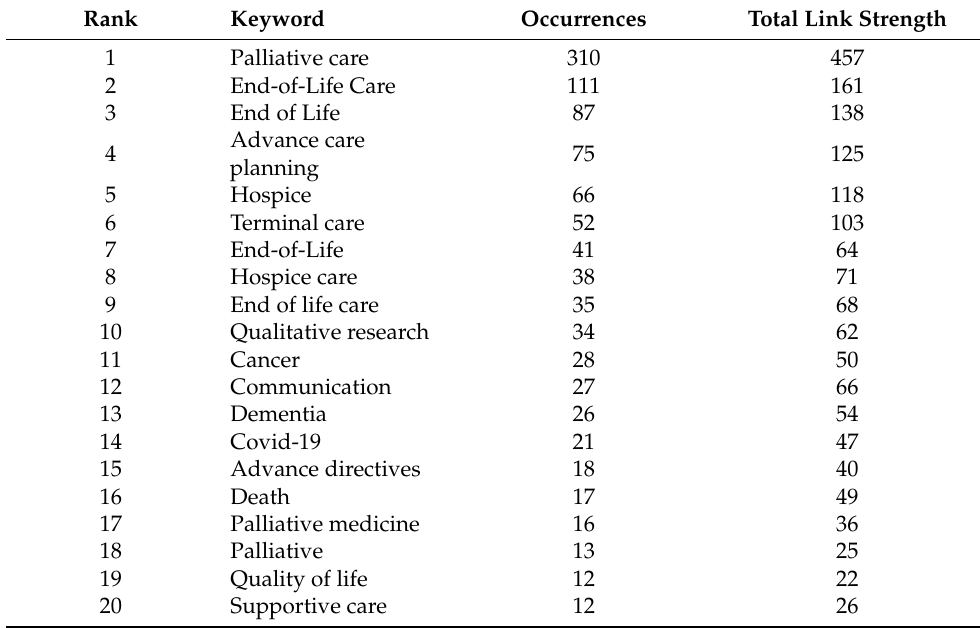
Table 6. 20 Most active keywords with more than 100